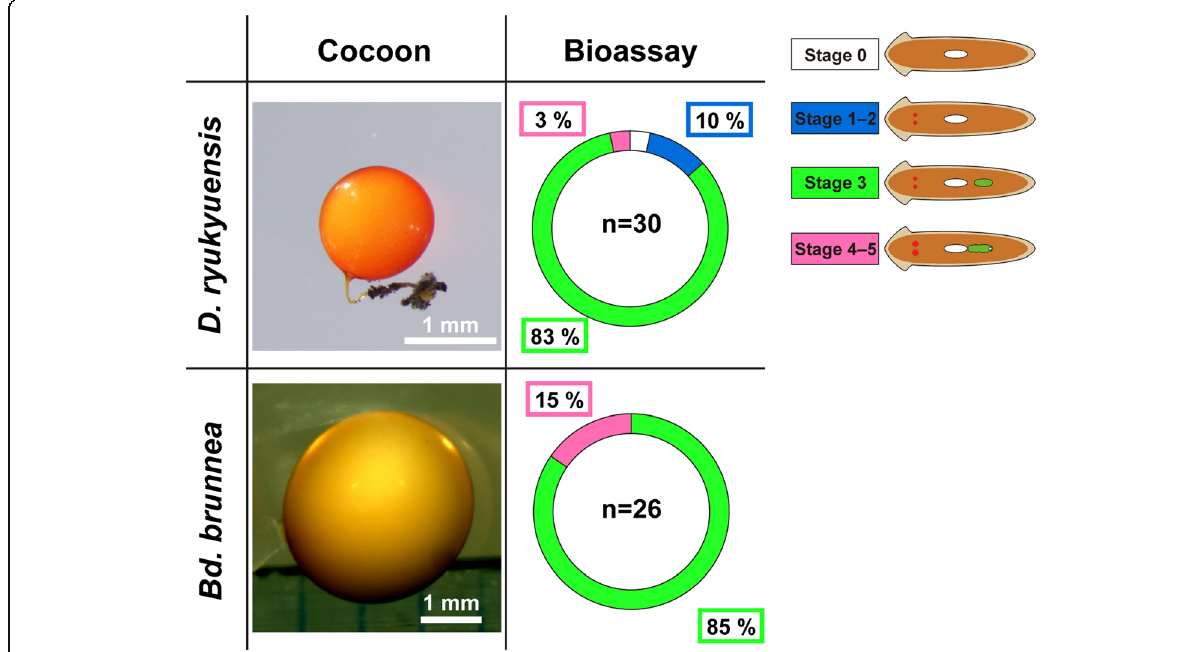
Fig. 8 Feeding experiment with cocoons laid by freshwater planarians. Thirty test worms were fed cocoons laid by Dugesia ryukyuensis or Bdellocephala brunnea daily for 4 weeks. The figure contains two photographs of cocoons laid by D. ryukyuensis or Bd. brunnea. Test worms at the three stages of sexual induction identified by external observation were expressed as a doughnut chart. The illustrations of worms in the figure correspond to those in Fig. 3b. The number of test worms after the bioassay is shown in the center of a doughnut chart. The percentage of worms at each of the three stages of sexual induction is shown in the box drawn by colored